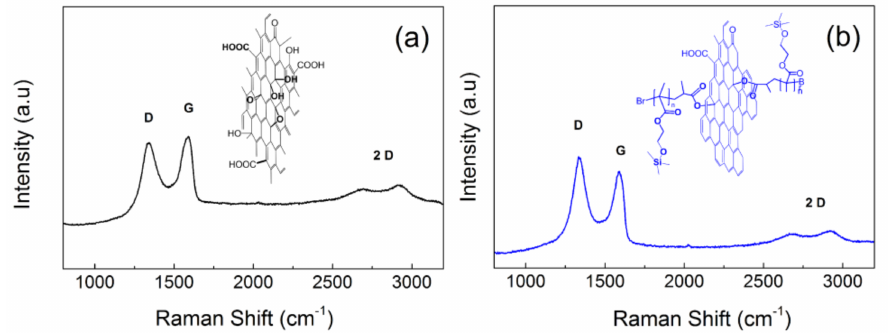
Figure 4. Raman spectra of the neat GO ( a ) and GO-PHEMATMS ( b ) particles and corresponding chemical structures.